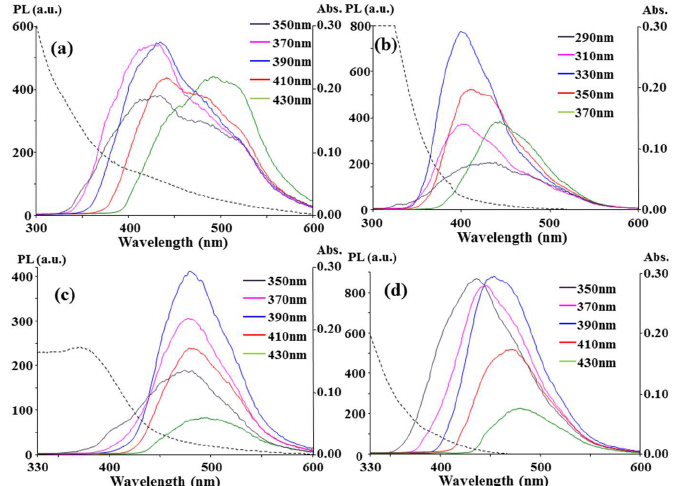
Figure 4. Fluorescence and UV-Vis absorption spectra for the CA + [EMIM]N(CN) 2 ( a , c ) and [EMIM]N(CN) 2 alone ( b , d ) samples heated in a 90 W microwave oven for 4.5 min ( a , b ) and in